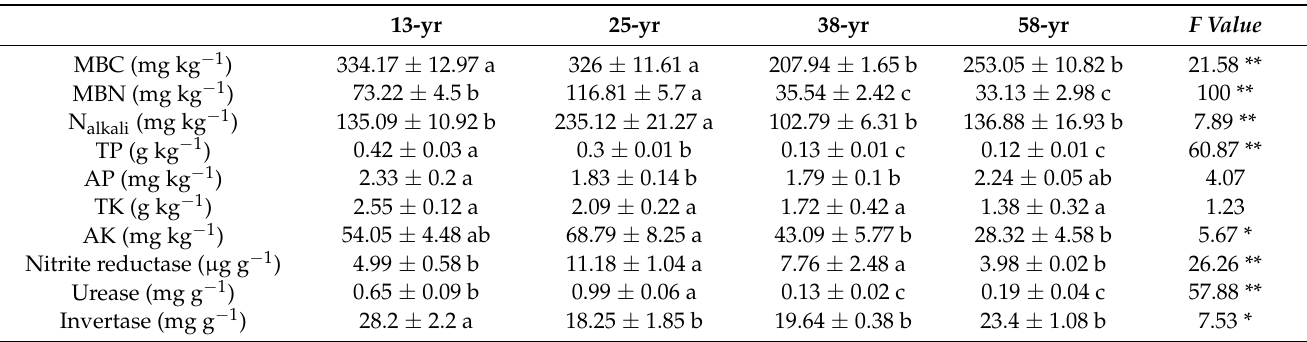
Table 1. Edaphic properties and enzyme activities according to four stand ages (Mean ± SE). Significance levels: ** p < 0.01, * p <